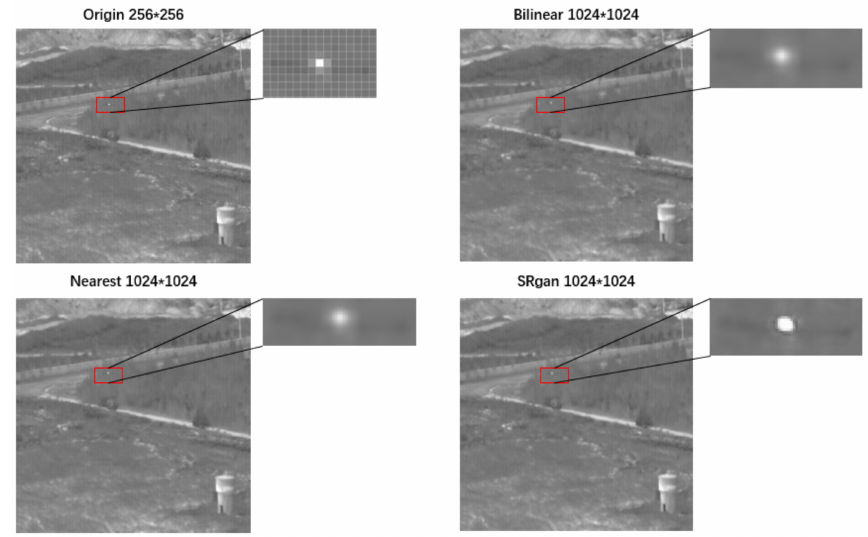
Figure 8. Image reconstruction of infrared small target by quadruple upsampling. PSNR is inversely proportional to the logarithm of mean square error (MSE) of the SR image, as shown in Formula (2). PSNR can reflect the noise level of the image and represent the distortion of the reconstructed image. The larger the value is, the better the reconstructed image will be.